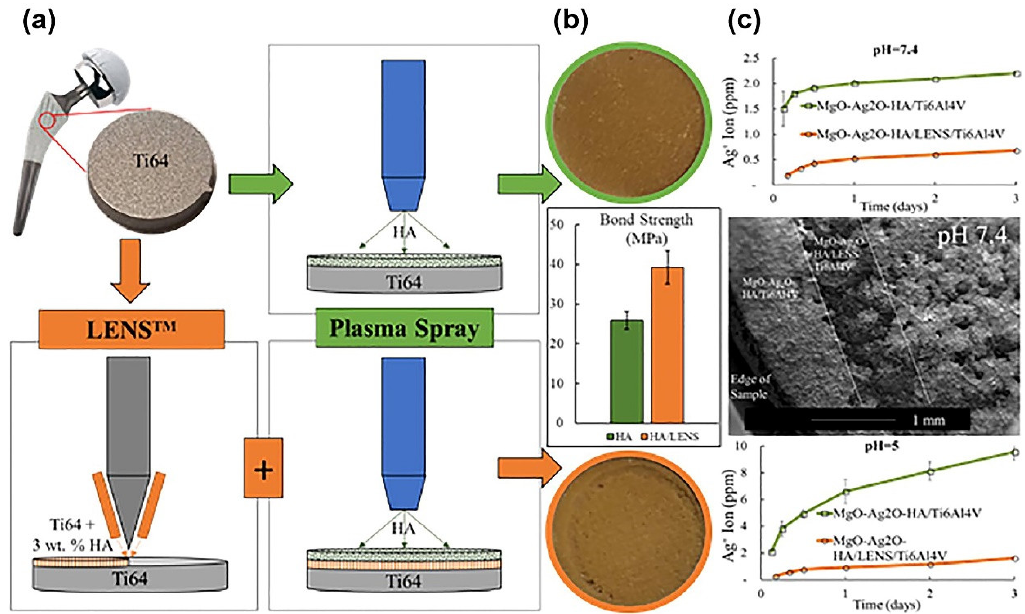
Figure 7. ( a ) Schematics during laser engineered net shaping (LENS TM ) and plasma-spraying Figure7. ( a )Schematicsduringlaserengineerednetshaping(LENS TM )andplasma-sprayingtreatments; treatments; ( b ) bond strength between HA and HA/LENS coatings and substrates; ( c ) accumulative ( b ) bond strength between HA and HA / LENS coatings and substrates; ( c ) accumulative Ag + release in MgO-Ag 2 O-HA / Ti-6Al-4V and MgO-Ag 2 O-HA / LENS / Ti-6Al-4V group. (Reproduced with permission Ag + release in MgO-Ag 2 O-HA/Ti-6Al-4V and MgO-Ag 2 O-HA/LENS/Ti-6Al-4V group. (Reproduced from [194]. Copyright Elsevier, with permission from [194]. Copyright Elsevier, 2019).